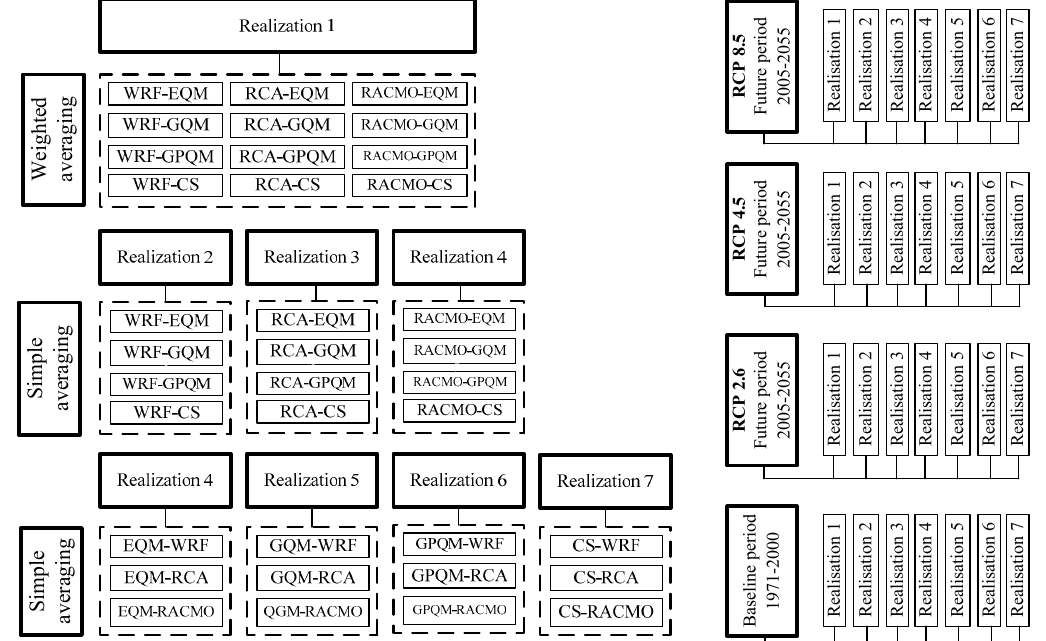
Figure 7. Climate scenarios within the Lim river basin: ( a ) Combination of RCMs (regional climate models), BCMs (bias correction methods), and averaging procedures, ( b ) realisations of each climate dataset combination for the baseline time period of 1971–2000 and future time period of 2006–2055 under RCP (representative concentration pathway) 2.6, RCP 4.5, and RCP 8.5.